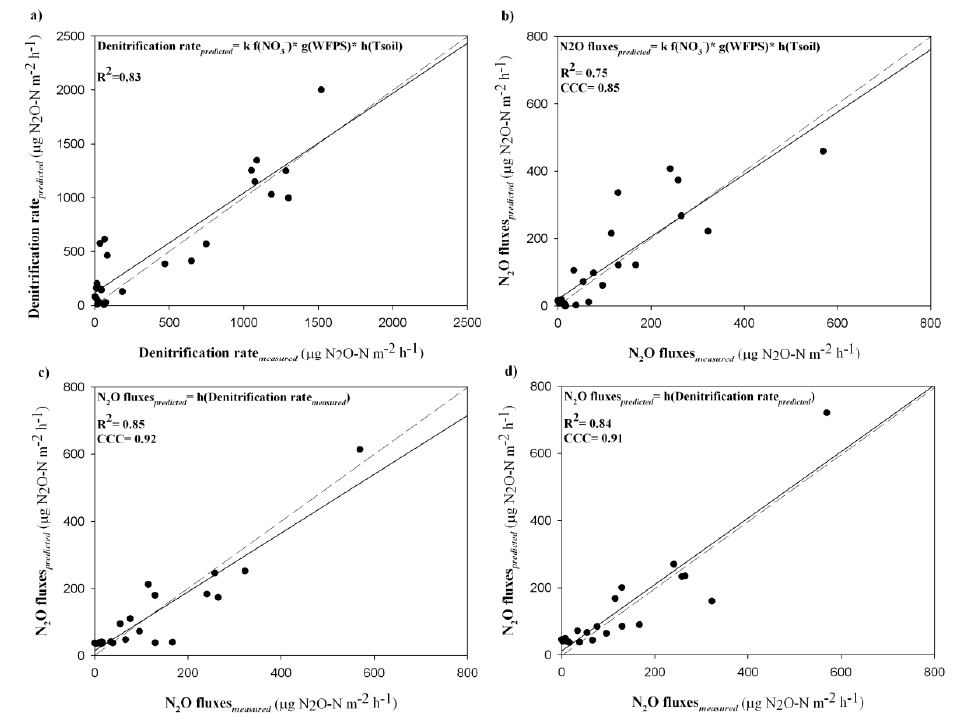
Figure 5. Coefficients and concordance correlation coefficients (CCC) relating to the comparison of measured and simulated denitrification rate and N 2 O fluxes through the four simple empirically derived predictiveequations: ( a ) equation (1) ; ( b ) equation (2) ; ( c ) equation (3) ; ( d ) equation (4) . The correction factors (k) of the predicting functions deriving the N 2 O fluxes and the denitrification rate from soil parameters were: 743.871 and 32.913 for equation (1) and (2) , respectively.